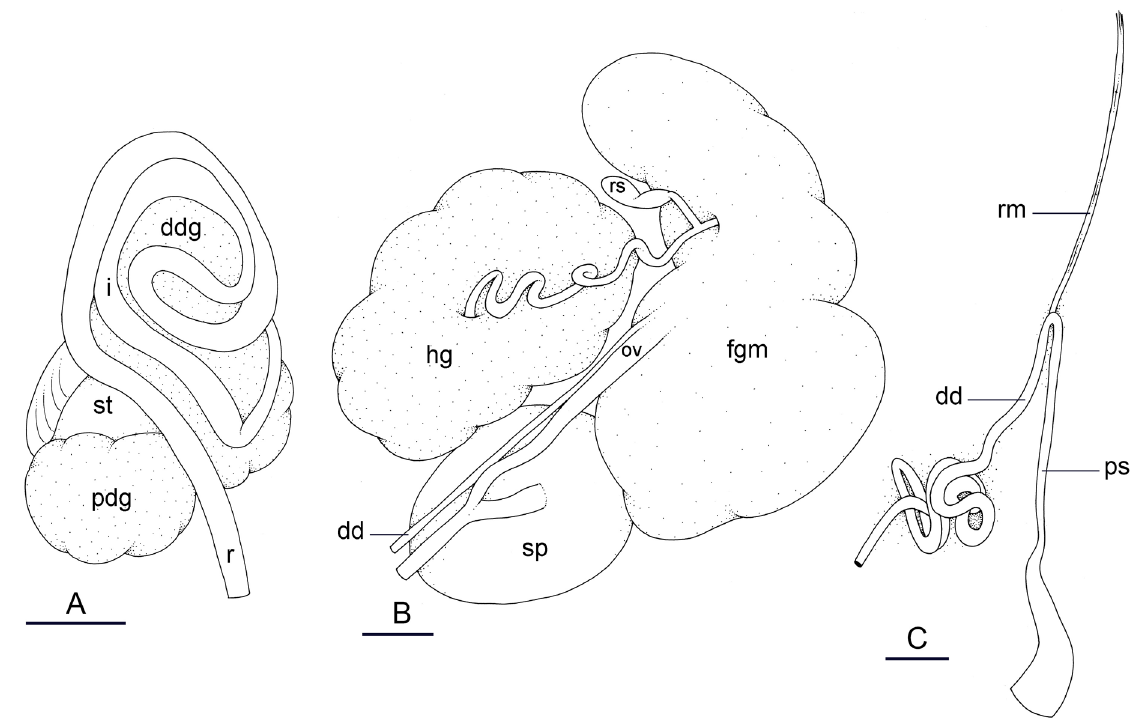
Fig. 48. Paromoionchis goslineri gen. et sp. nov. unit #2, Indonesia, Sulawesi [2241] (UMIZ 00153). A . Digestive system. B . Posterior hermaphroditic (female) reproductive system. C . Male copulatory organs. Abbreviations: dd = deferent duct; ddg = dorsal lobe of digestive gland; fgm = female gland mass; hd = hermaphroditic duct; hg = hermaphroditic gland; i = intestine; ov = oviduct; pdg = posterior lobe of digestive gland; ps = penial sheath; r = rectum; rm = retractor muscle; rs = receptaculum seminis; sp = spermatheca; st = stomach. Scales: A = 2 mm; B–C = 1